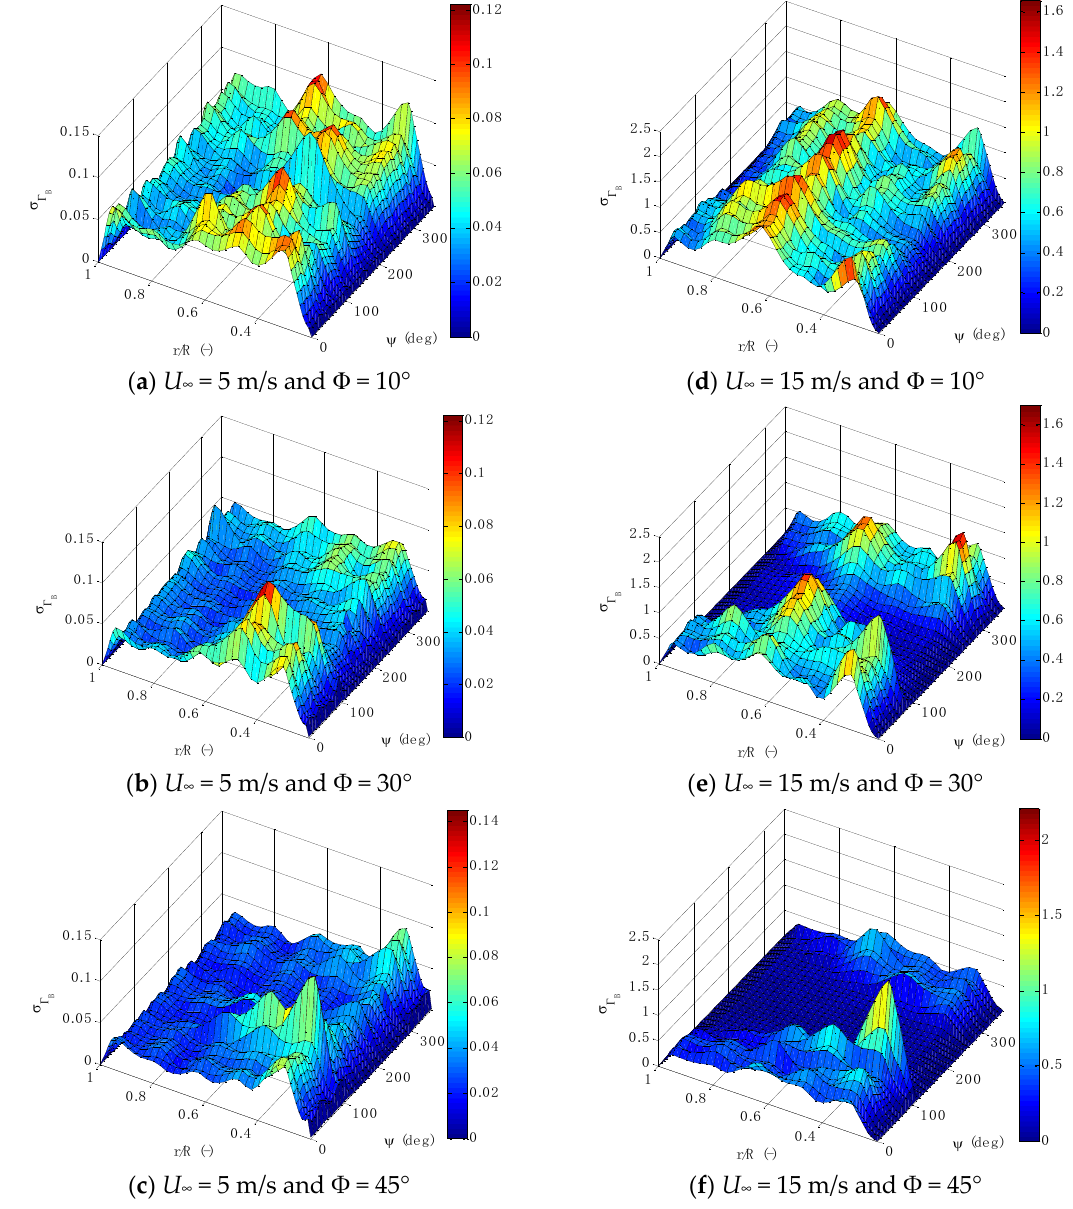
Figure 9. Standard deviation of the bound circulation at 5 and 15 m/s.